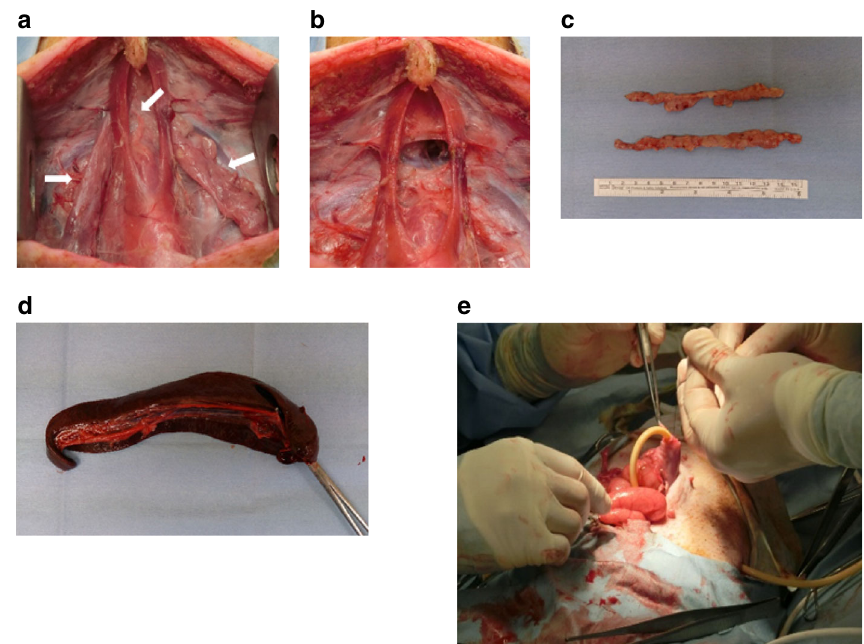
Fig. 1 Thymectomy, splenectomy, and gastrostomy of a mini-pig. The image of the ventral cervical region of the neck before thymectomy. The white arrow indicates the lobes of the thymus a . An image of the ventral cervical region of the neck after thymectomy b . An image of the resected thymus c . An image of the resected spleen d . An image of gastrostomy performed under laparotomy